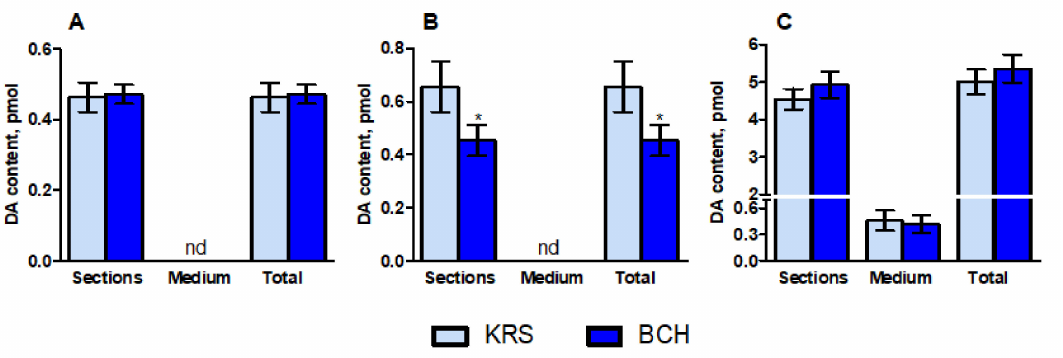
Figure 2. Dopamine content in vibratome sections of the periventricular nucleus ( A ), arcuate nu- cleus ( B ), and substantia nigra ( C ) after their incubation in Krebs–Ringer solution (KRS) in the presence or absence of 0.5 mM 2-amino-2-norbornanecarboxylic acid (BCH), and in the incubation medium, as well as the total dopamine content in the incubation medium and vibratome sections. * p < 0.05, significant differences in dopamine content after the incubation of vibratome sections with or without BCH; nd, not